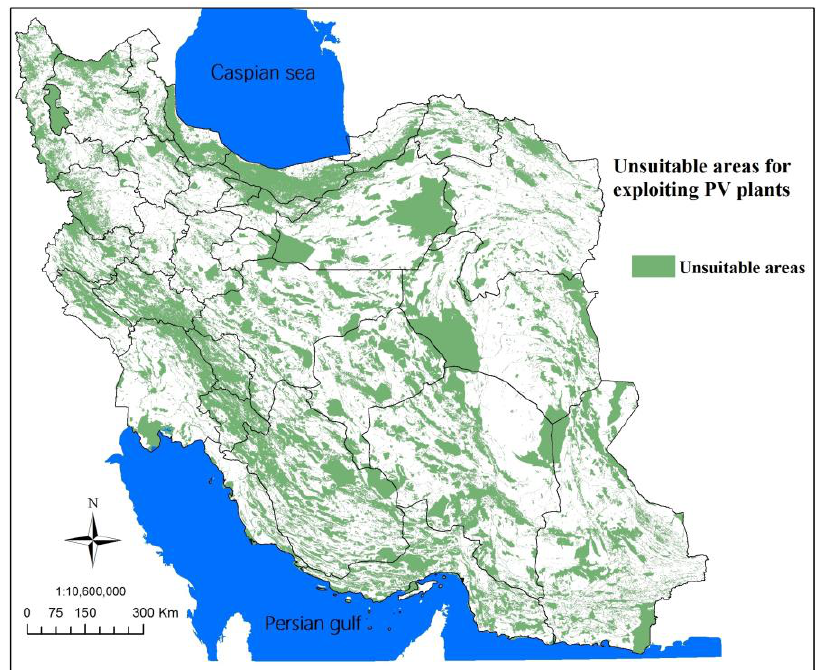
Figure 2. Final map of unsuitable areas.